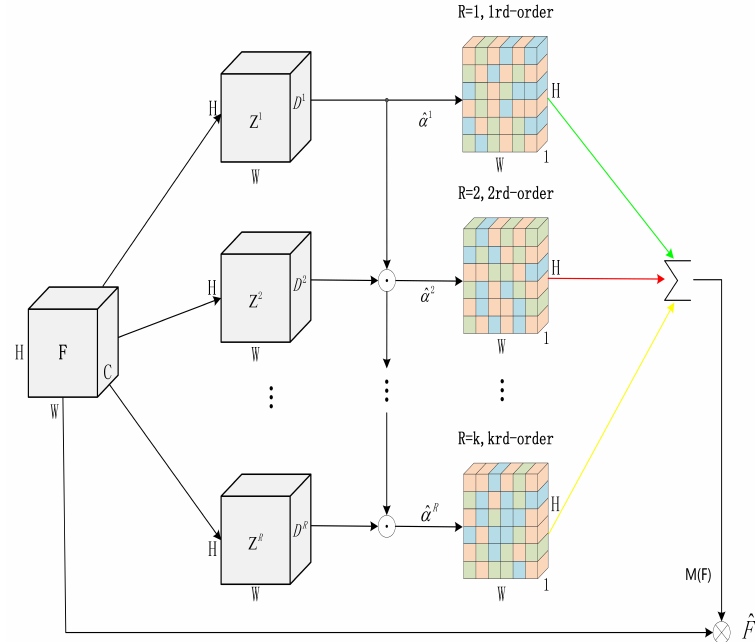
Figure 2. Illustration of the high-order spatial attention